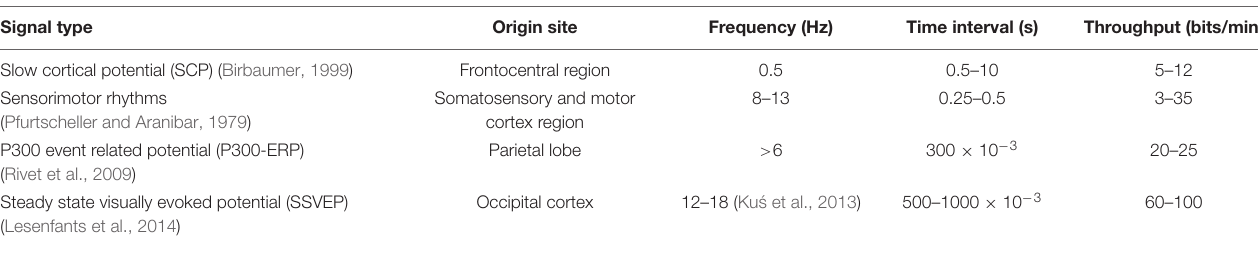
TABLE 1 | Types of brain signals recorded using non-invasive BMIs. Signal